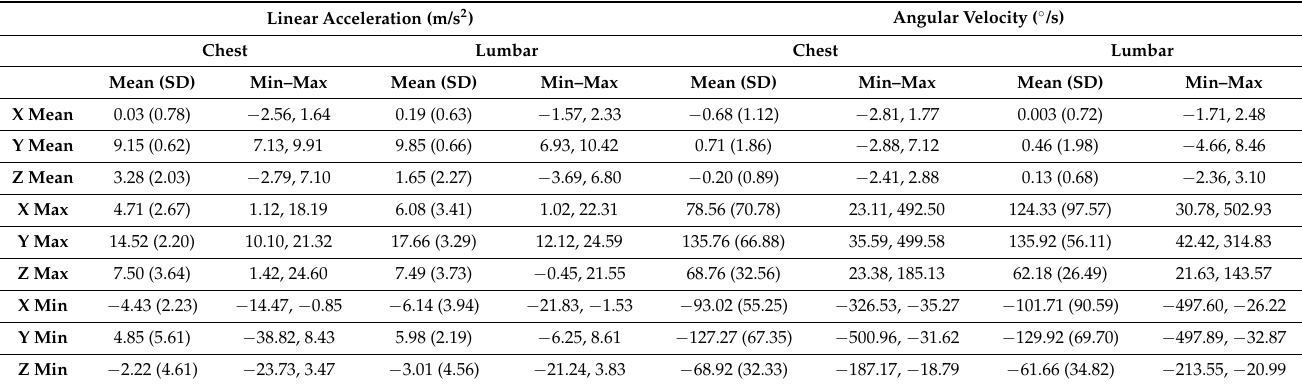
Table 1. Lumbar and chest linear acceleration and angular velocity in the three dimensions during the